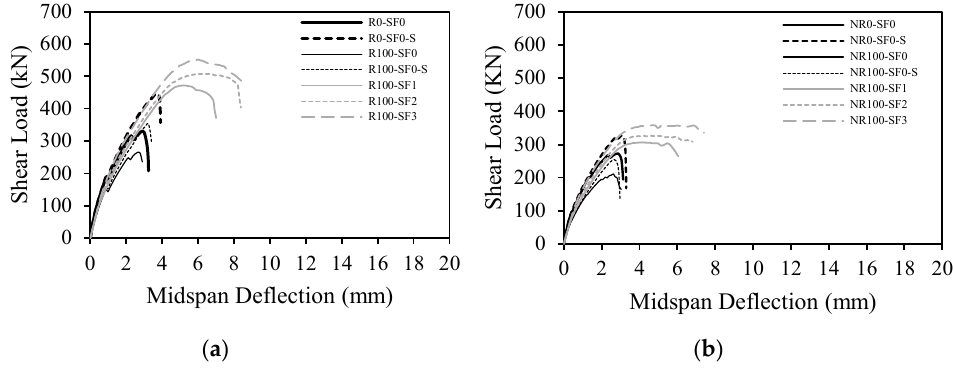
Figure 22. Shear load–deflection responses: ( a ) solid models; ( b ) models with web openings.